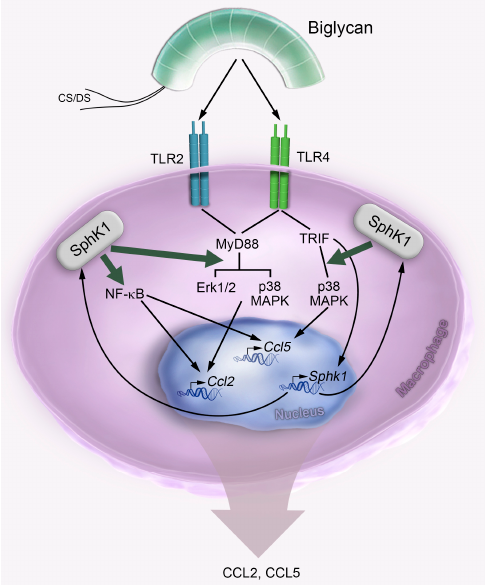
Figure 7. A working model summarizing the mechanisms of biglycan-driven and Sphk1 -mediated production of macrophage chemoattractants CCL2 and CCL5. Following release from the ECM, biglycan interacts with TLR2 and -4 and triggers production of CCL2 and CCL5 through TLR2/4/MyD88 and TLR4/TRIF, respectively. By signaling via TLR4, biglycan induces the Sphk1 synthesis in a TLR4/TRIF- dependent manner. Moreover, biglycan induces the activity of SphK1. In turn, active SphK1 drives the biglycan-mediated production of CCL2 through Erk1/2 p38 MAPK and NF- κ B activation, while CCL5 is induced only through p38 MAPK and NF- κ B activation. Consequently, this leads to the recruitment of macrophages to inflamed tissues. Green arrows underline the effect of SphK1 on the biglycan-promoted NF- κ B activation, MyD88/Erk1/2/p38 MAPK and TRIF/p38 MAPK pathways. Black arrows describe the